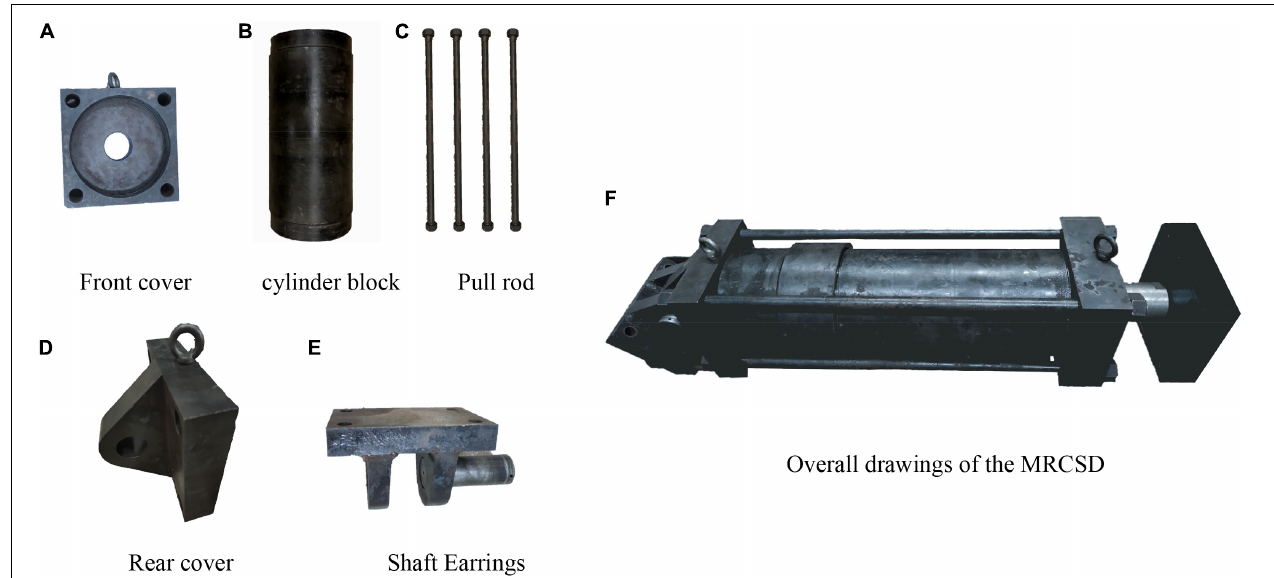
FIGURE 5 | Main components and overall drawings of the MRCSD: (A) front cover, (B) cylinder block, (C) pull rod, (D) rear cover, (E) shaft earrings, and (F) overall drawings of the